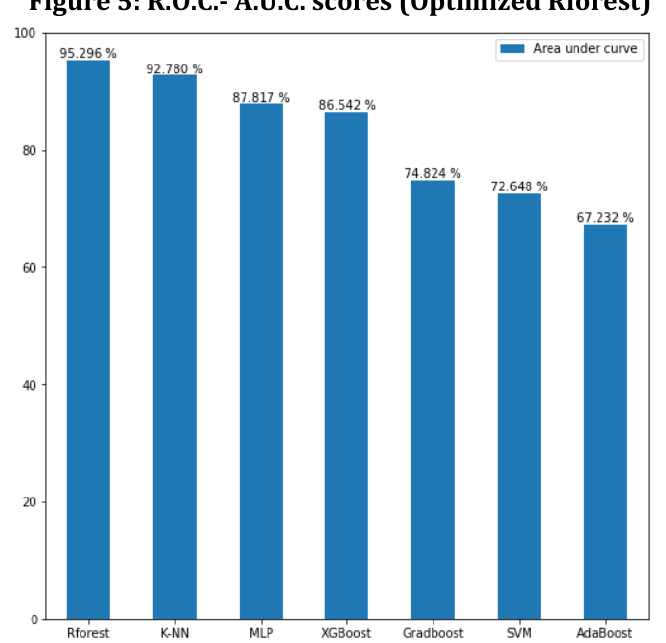
Figure 5: R.O.C.- A.U.C. scores (Optimized